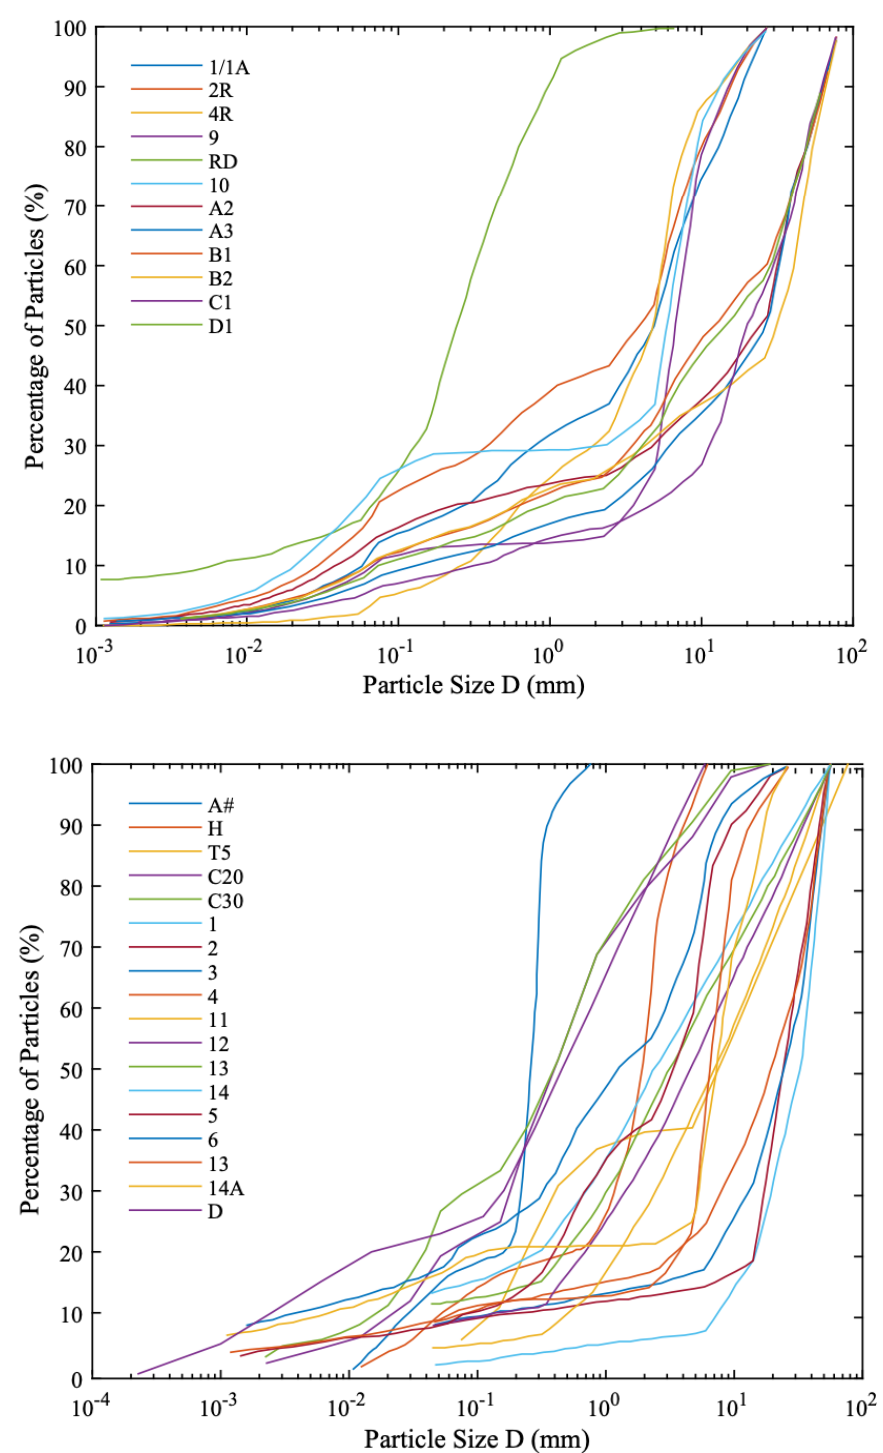
Figure A1. PSD curves of the 80 studied soil specimens.